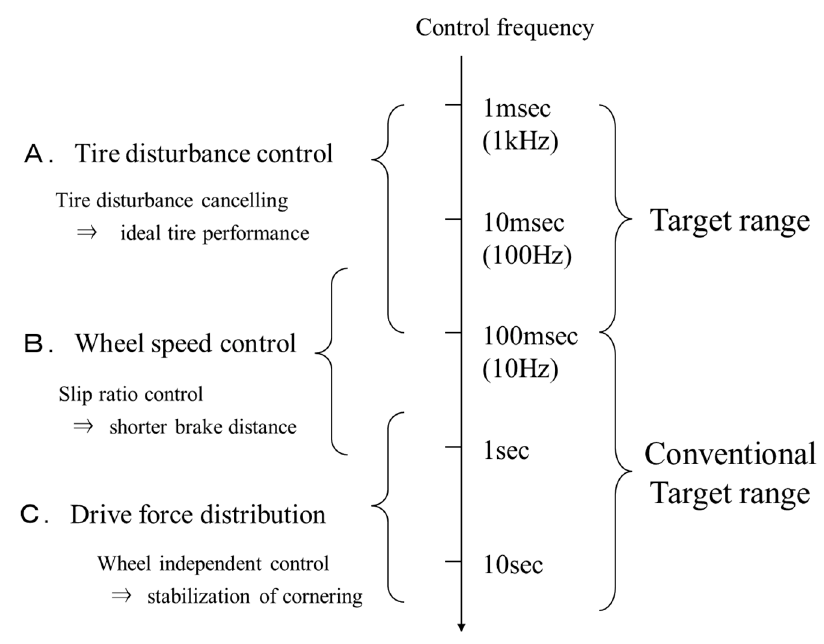
Figure 1. Control system corresponding to control frequency range.